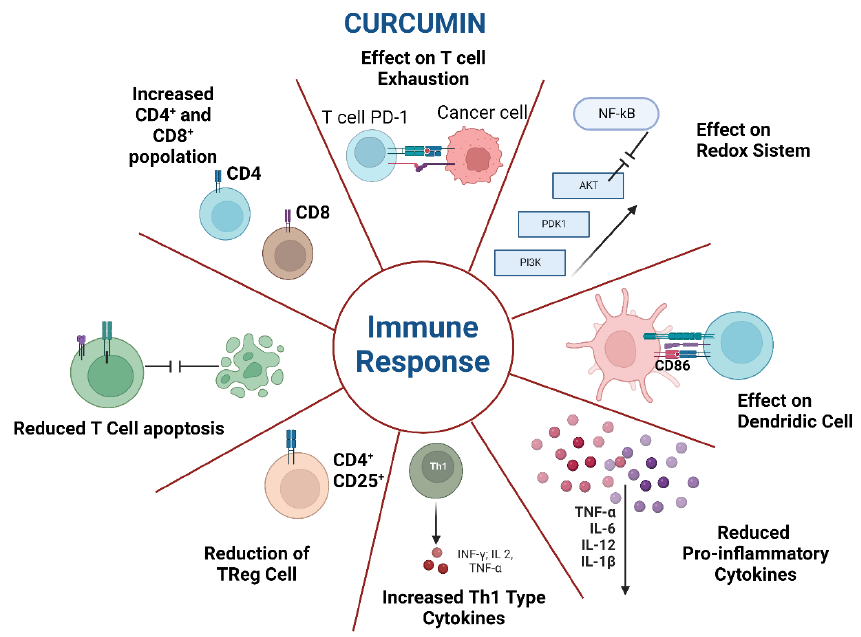
Figure 2. Effects of curcumin on immunological effectors.